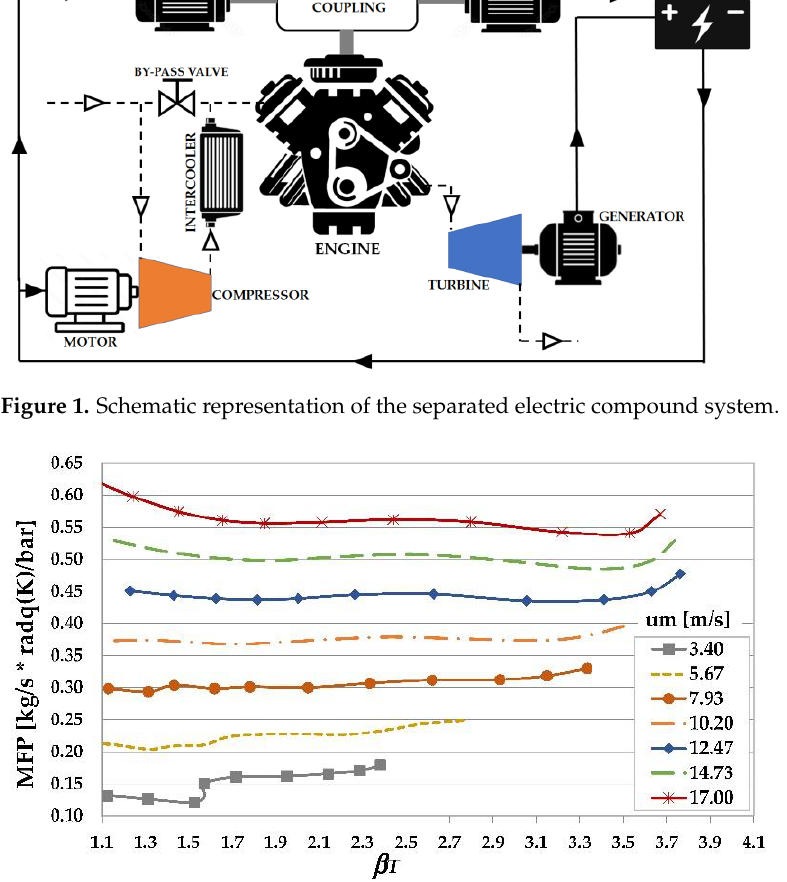
Figure 1. Schematic representation of the separated electric compound system.